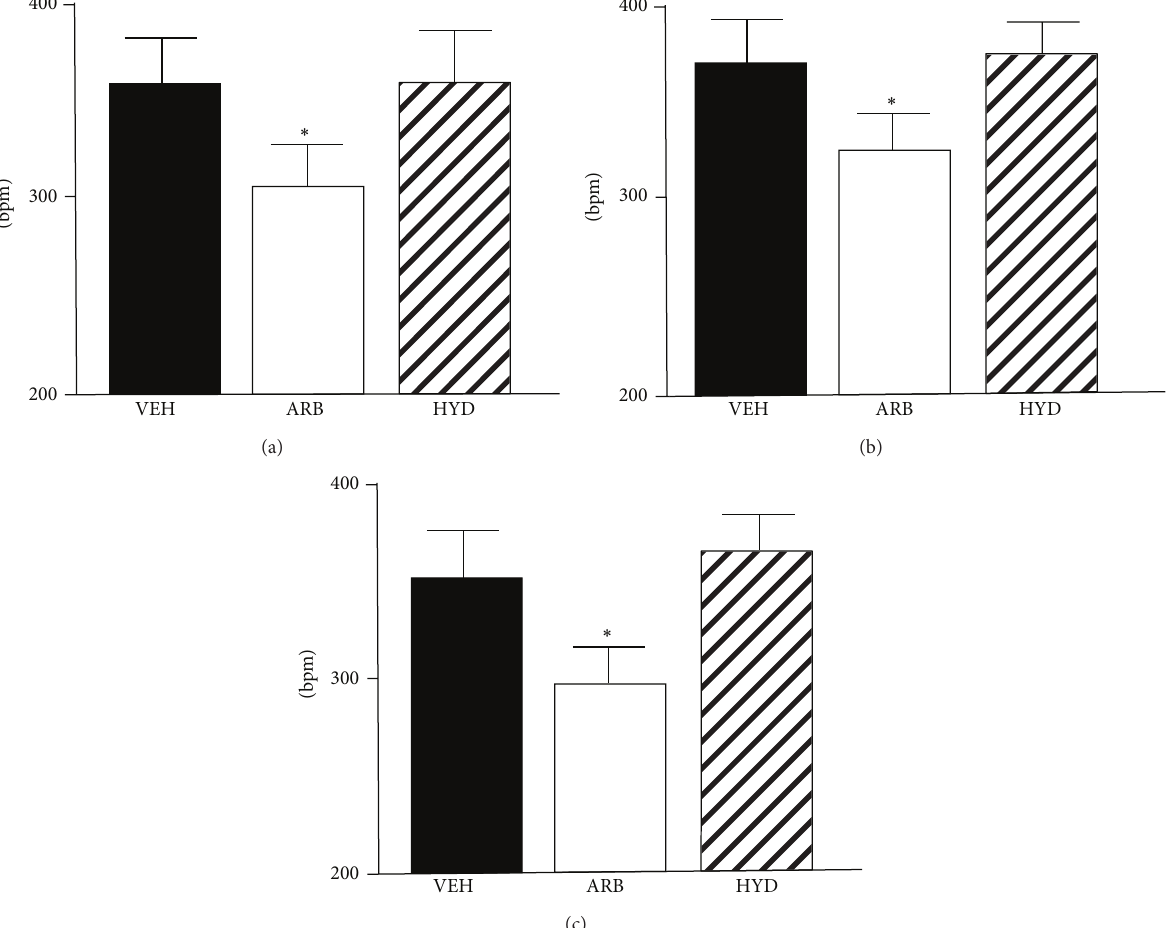
Figure 2: Telemetric averaged heart rate in stroke-prone spontaneously hypertensive rats treated with intracerebroventricular infusion of losartan (ARB, 𝑛 = 5 ), oral-administered hydralazine (HYD, 𝑛 = 5 ), and intracerebroventricular infusion of vehicle (VEH, 𝑛 = 5 ) at early morning (a), after morning (b), and night (c). ∗ 𝑃 < 0.05 versus